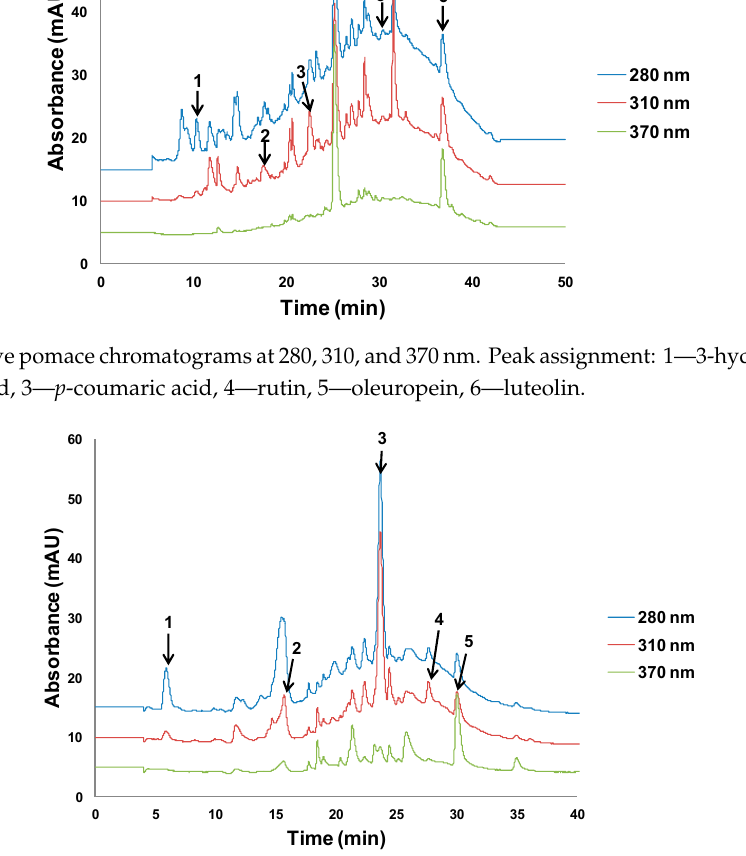
Figure 3. Lees filter chromatograms at 280, 310, and 370 nm. Peak assignment: 1—gallic acid, 2—caffeic acid, 3—hesperidin, 4—resveratrol, 5—quercetin.